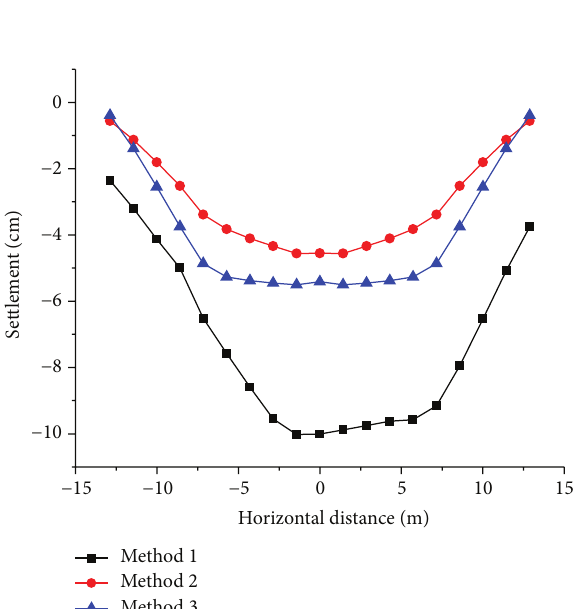
Figure 4: Ground settlement curves.